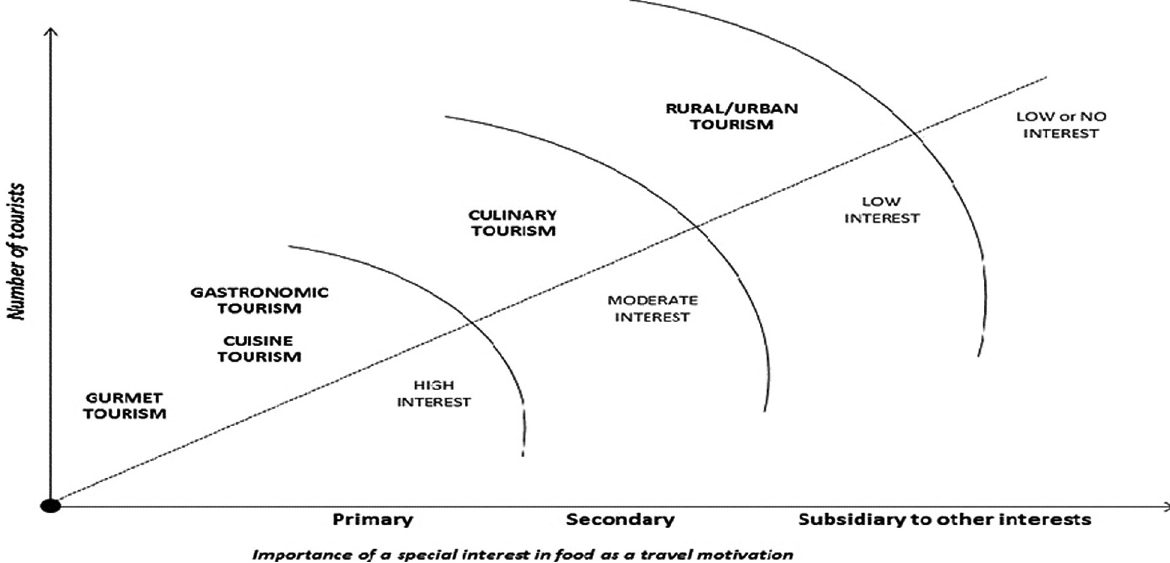
Fig. 1. Types of tourism relying upon the degree of the enthusiasm for food degustation and in culinary items by Hall and Sharples